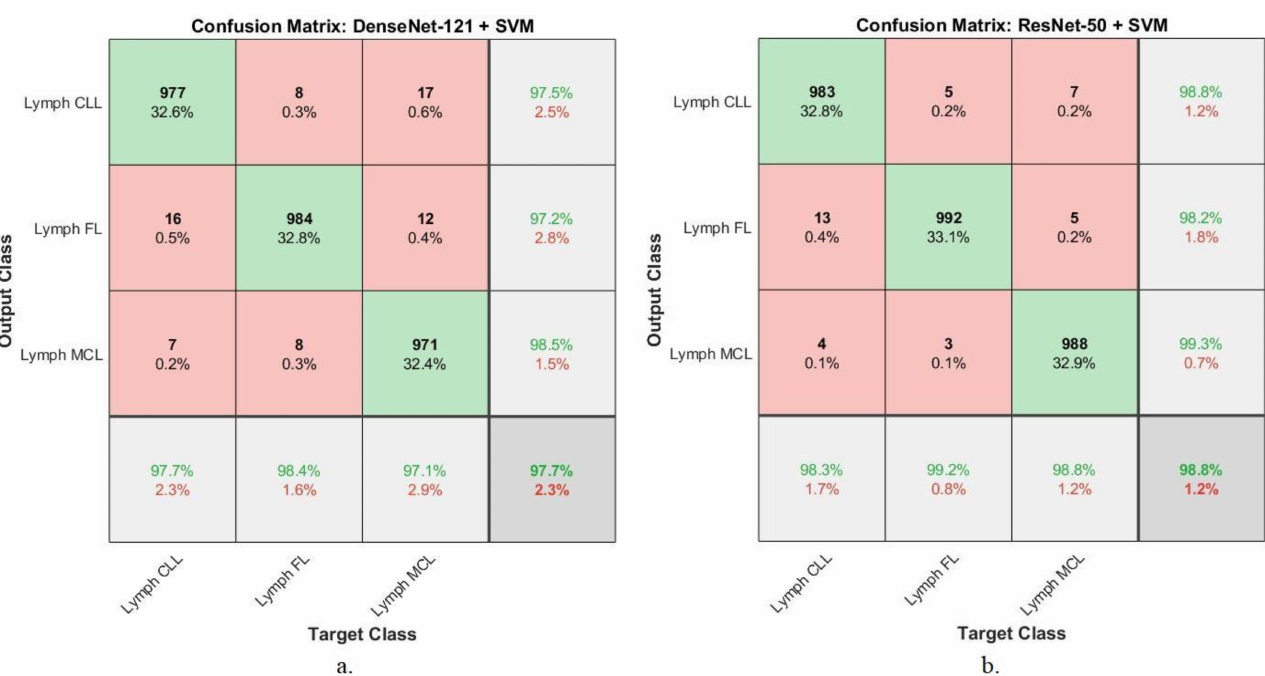
Figure 6. Presentation of the performance of the hybrid system for diagnosing malignant lymphomas. Figure7summarizestheconfusionmatrixfortheDenseNet-121+SVMandResNet-50 + SVM systems in diagnosing the three types of malignant lymphoma of the first dataset. The DenseNet-121 + SVM achieved an accuracy of 97.7%, 98.4%, and 97.1% in the classification of CLL, FL, and MCL (malignant tumors), respectively. In contrast, ResNet-50 + SVM yielded an accuracy of 98.3%, 99.2%, and 98.8% in the detection of the CLL, FL, and MCL types, respectively.